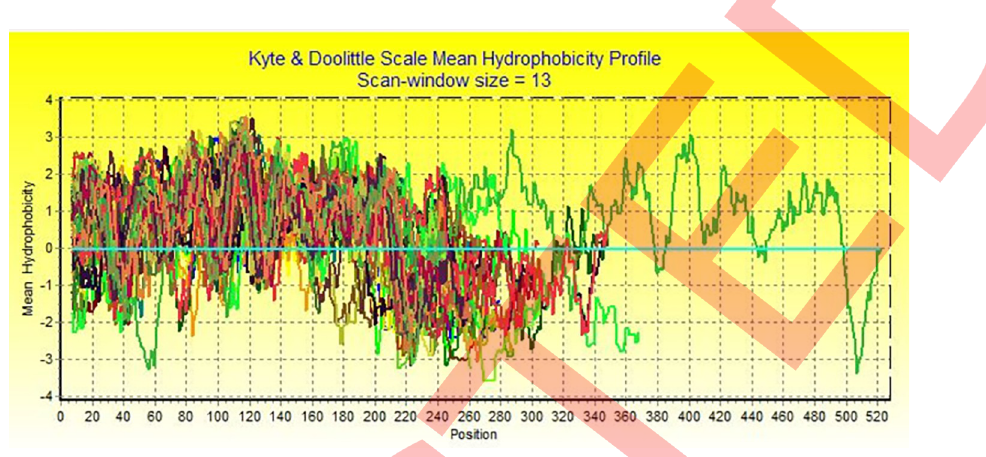
Fig 4. Graphical representation (A) hydrophobicity and (B) hydrophilicity 155 SWEET proteins were estimated by Kyte and Doolittle scale mean hydrophobic scale and Bokyo scale mean hydrophobicity profile method. The plot has an amino acid sequence of SWEET proteins on its X-axis and degree of hydrophobicity on its Y-axis. The hydrophobicity index is a measure of an amino acid’s relative hydrophobicity, or how soluble it is in water. Hydrophobic amino acids are more likely to be located in the inner part of a protein, whereas hydrophilic amino acids are more likely to be in touch with the aqueous environment. SWEET proteins are highly hydrophobic and thermostable in nature which plays an important role in structuring and maintaining protein structure.